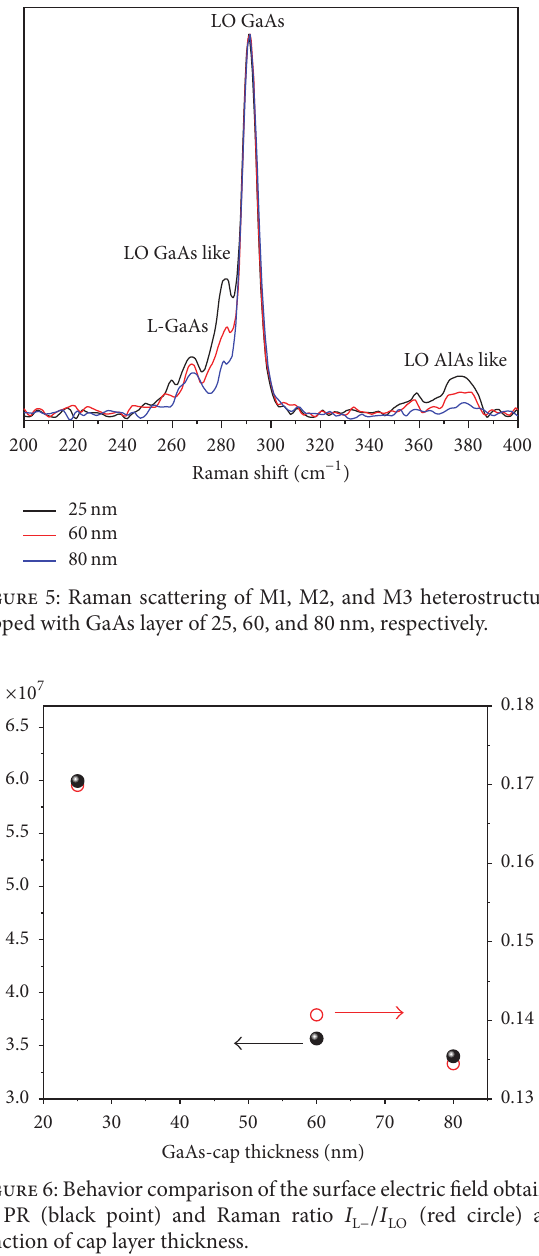
/𝐼 (red circle) as a L − LO